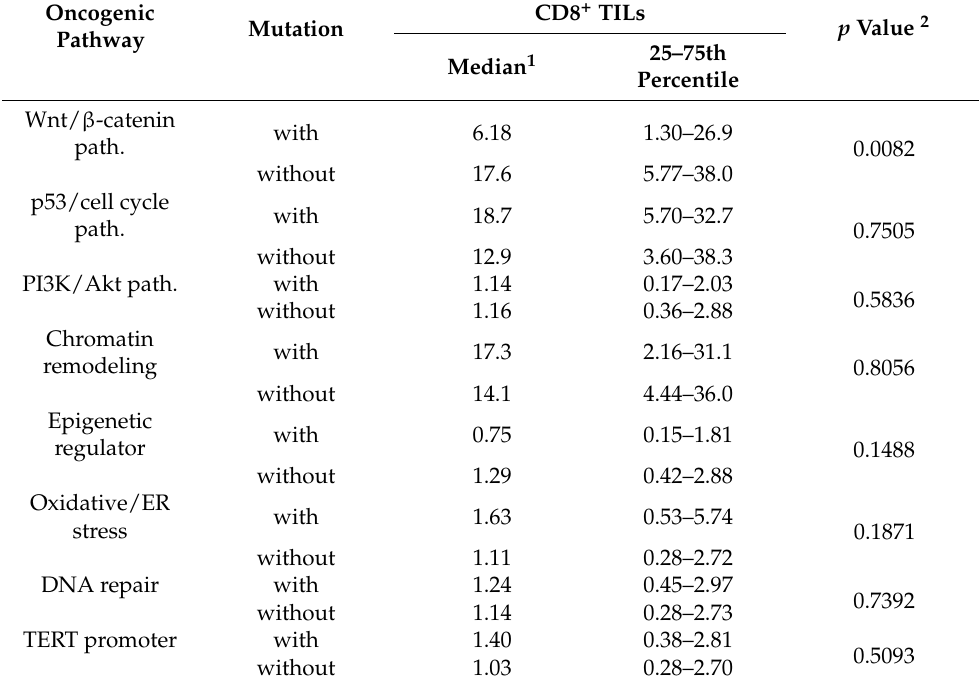
Table 2. Association between alterations in oncogenic signaling pathways and the degree of CD8 + tumor infiltrating